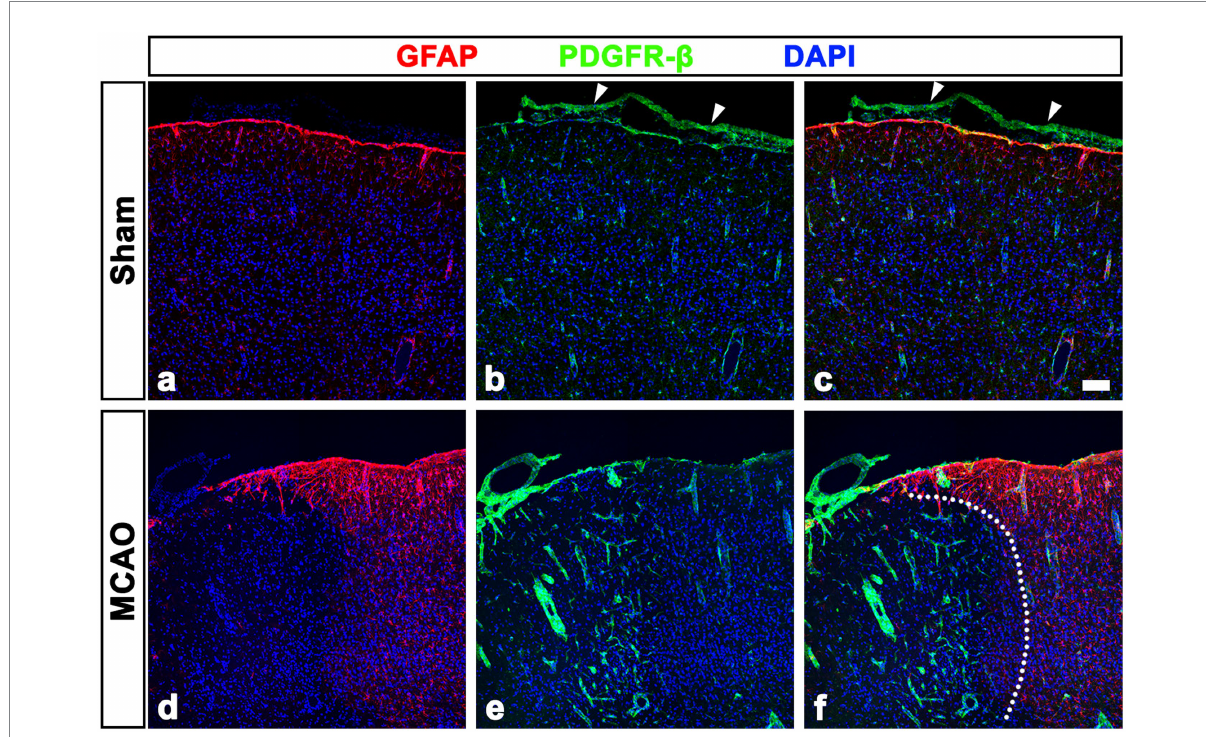
FIGURE 2 PDGFR- β expression profiles in the leptomeninges and underlying cortex of sham-operated and MCAO rats. (A–C) Double labeling for PDGFR- β and GFAP in control sections showing that PDGFR- β is expressed in the leptomeninges (arrowheads in B and C ) and cortical vessels but not in the GFAP-positive glia limitans superficialis covering the cortical surface. (D–F) Double labeling for PDGFR- β and GFAP in the cortex reperfused for 3 days showing that PDGFR- β expression is prominent in vascular profiles in the lesion core, where GFAP immunoreactivity is absent. The broken line indicates the border between the lesion core and the peri-lesional area. Scale bar = 100 μ m for (A–F)